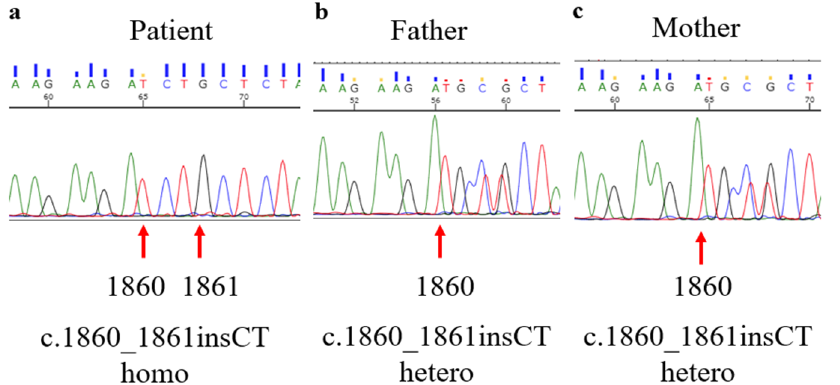
Figure 6. Genetic analysis using Sanger sequencing of ( a ) the patient, ( b ) the patient’s father, and ( c ) the patient’s mother. Stop mutation c.1860_1861insCT (p.Ala621LeufsTer59) in SPEF2 in a homozygous state was observed in ( a ) the patient and the heterozygous mutations were found in ( b , c ) the patient’s father and mother. SPEF2 = sperm flagellar 2. Green: adenine (A). Black: guanine (G). Red: thymine (T). Blue: cytosine (C).